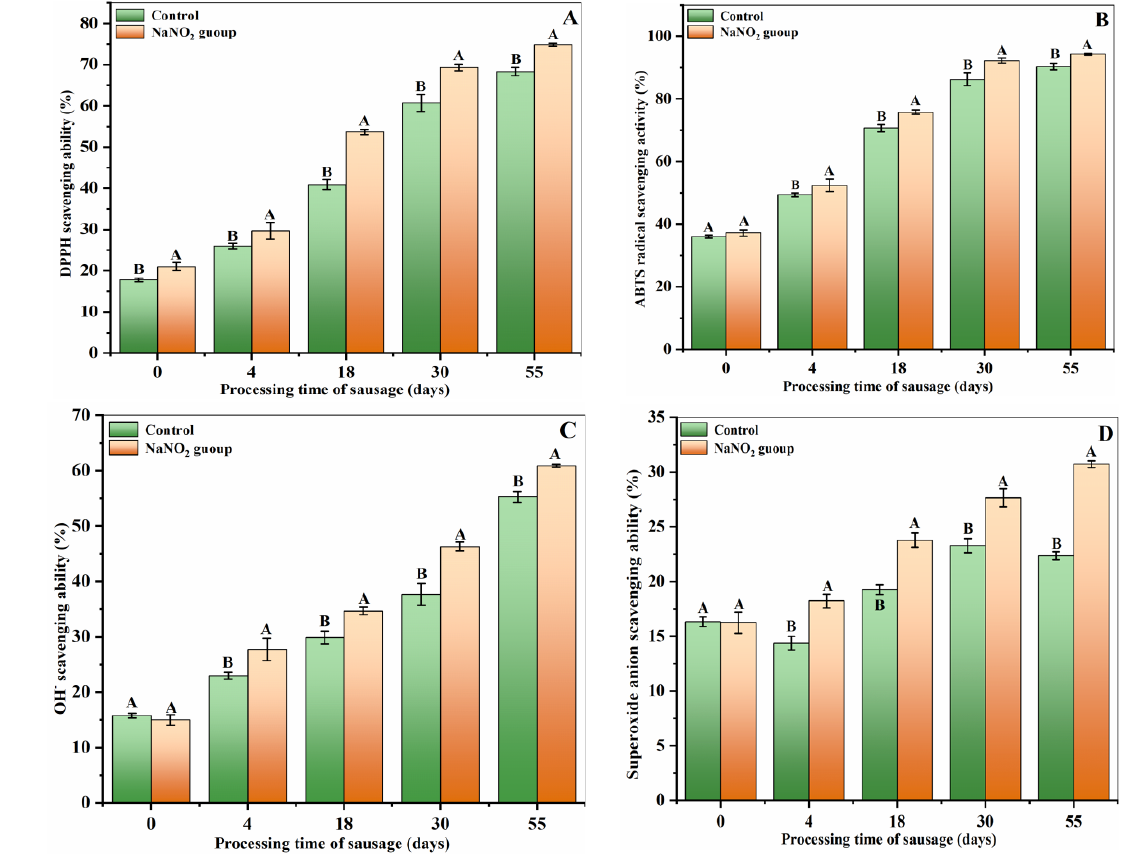
Figure 3. Changes in the antioxidant capacity: ( A ) DPPH scavenging ability, ( B ) ABTS scavenging ability, ( C ) hydroxyl radical scavenging ability, ( D ) superoxide anion free radical scavenging ability) of polypeptides during sausage processing. Different uppercase letters in a column indicate significant differences among various treatments during storage time (days) for each treatment ( p < 0.05).